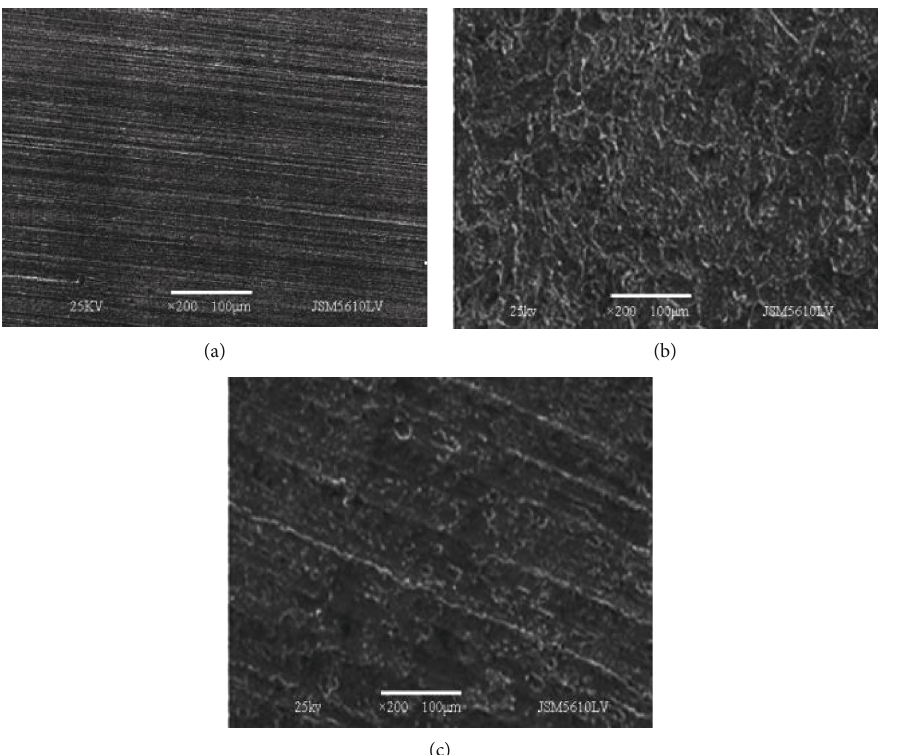
Figure 18: SEM images of corrosion inhibition performance analysis of carbon steel (a) before experiment, (b) without adding CNS-PESA, and (c) with adding